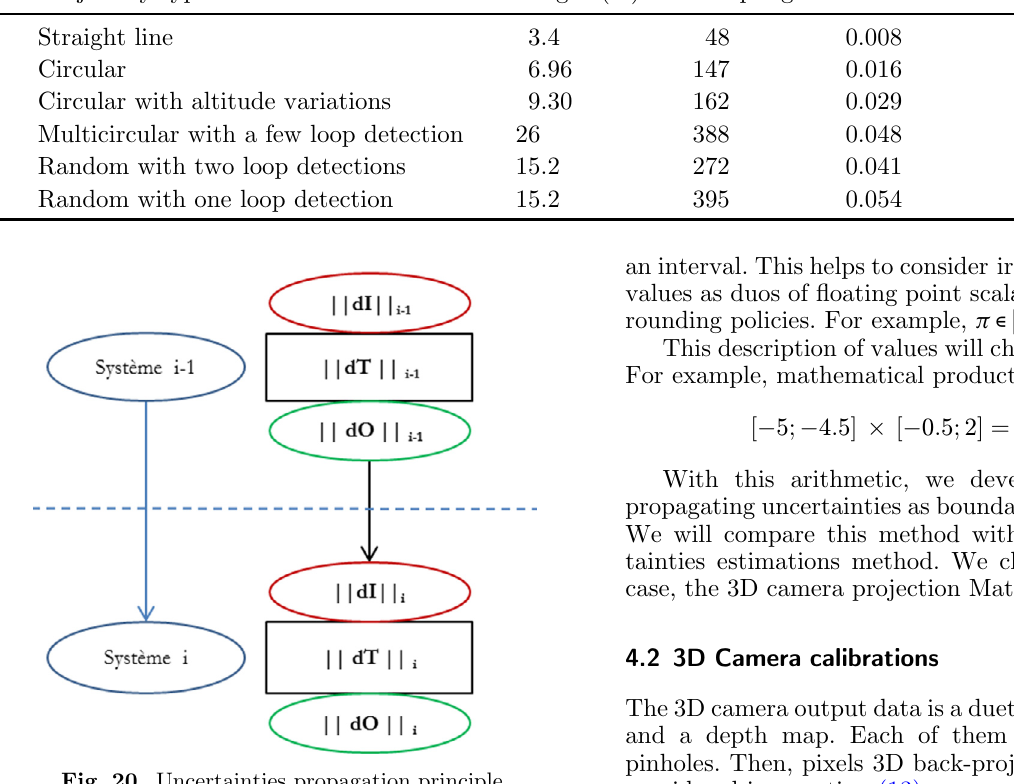
Fig. 20. Uncertainties propagation